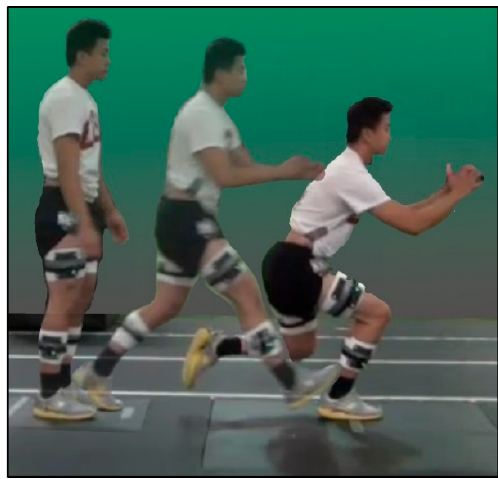
Figure 2. Single Limb Loading Test.